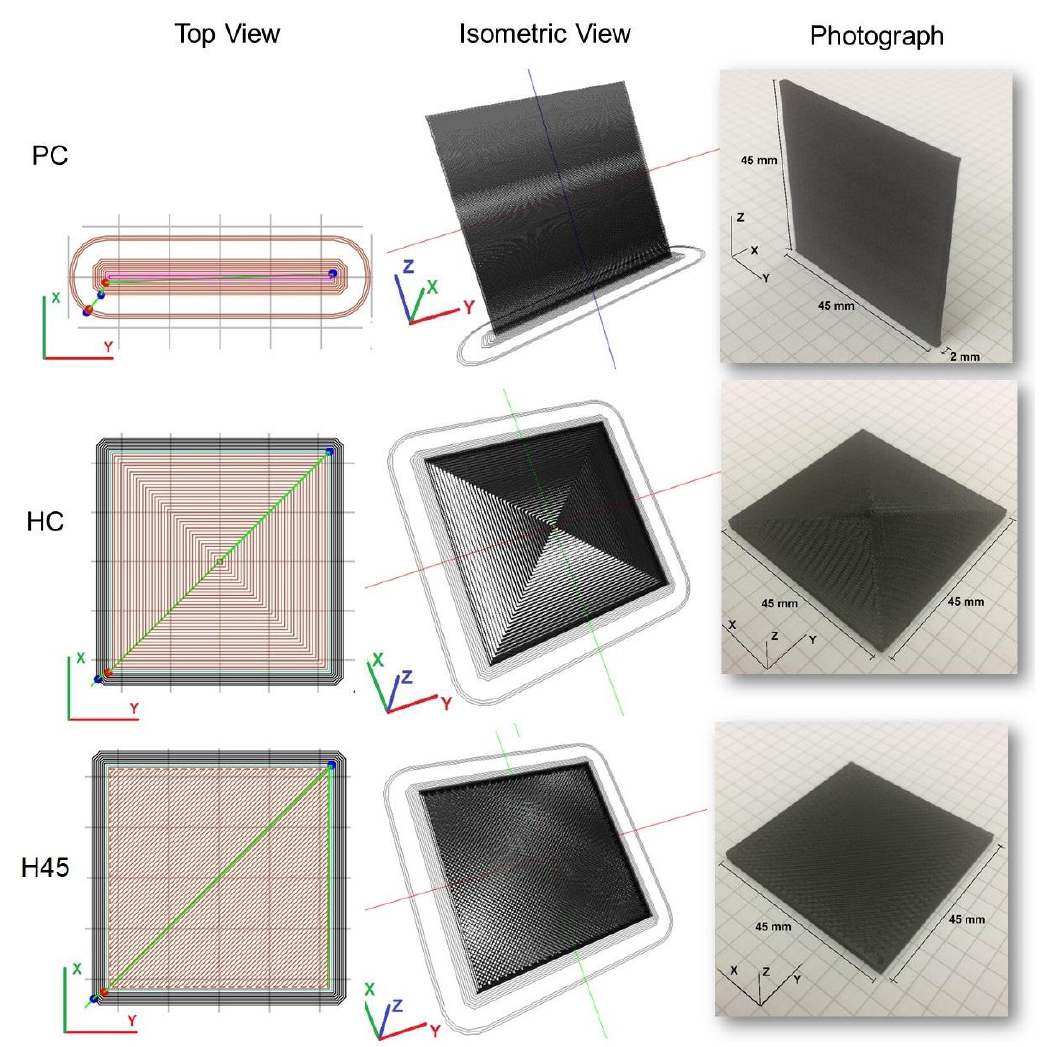
Figure 2. Scheme of the fused deposition modeling (FDM) 3D manufactured samples for Figure 2 . Scheme of the fused deposition modeling (FDM) 3D manufactured samples for electromagnetic interference shielding efficiency (EMI SE) electromagnetic interference shielding efficiency (EMI SE) tests.